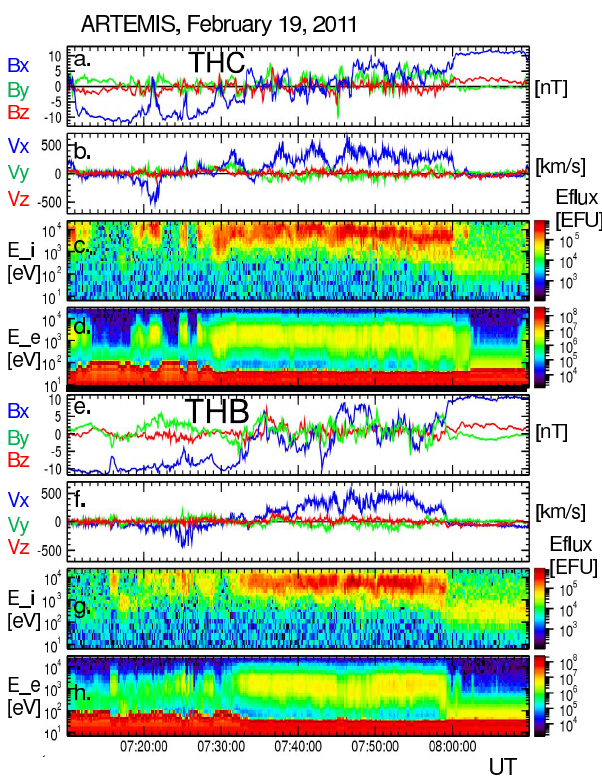
Fig. 2. ARTEMIS observations; (a–d) THC probe; (e–h) THB probe; (a) and (e) magnetic field GSM components; (b) and (f) plasma speed GSM components; (c, d) and (g, h) ion and elec- tron energy flux spectrograms; EFU stays for Energy Flux Unit in (eV/cm − 2